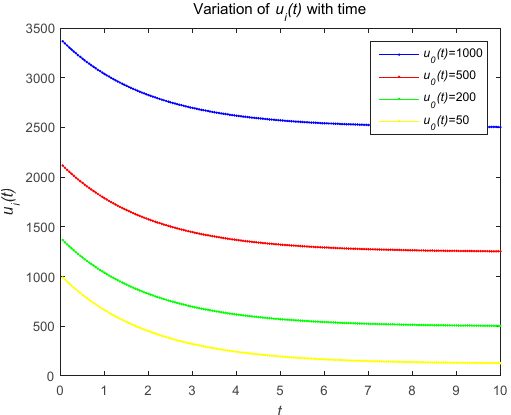
( ) ( t ) over u t over time. Figure 2. Optimal strategy of the attacker with different u 0 0